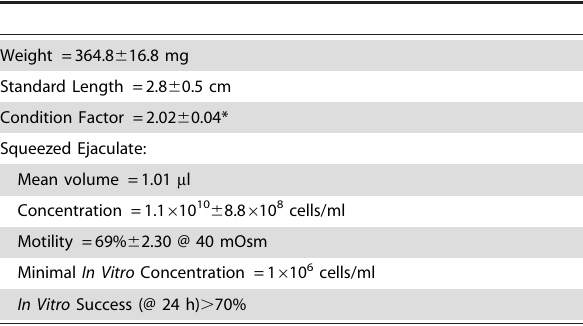
Table 1. Mean ( 6 SEM) Reproductive Characteristics of Male